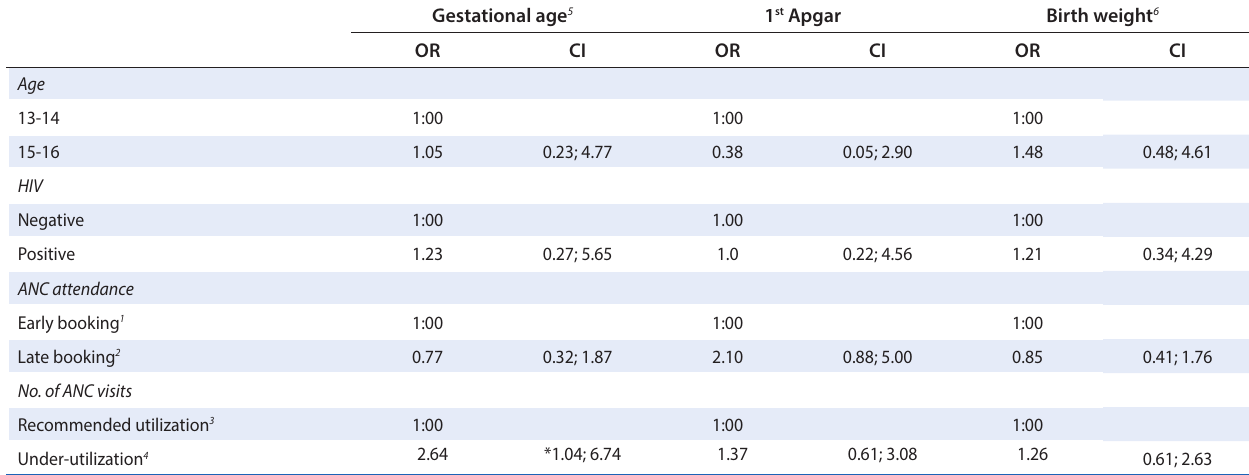
Table 3: Adjusted logistic regression models of birth outcomes stratified by age, HIV status, and ANC utilisation ( n = 314)